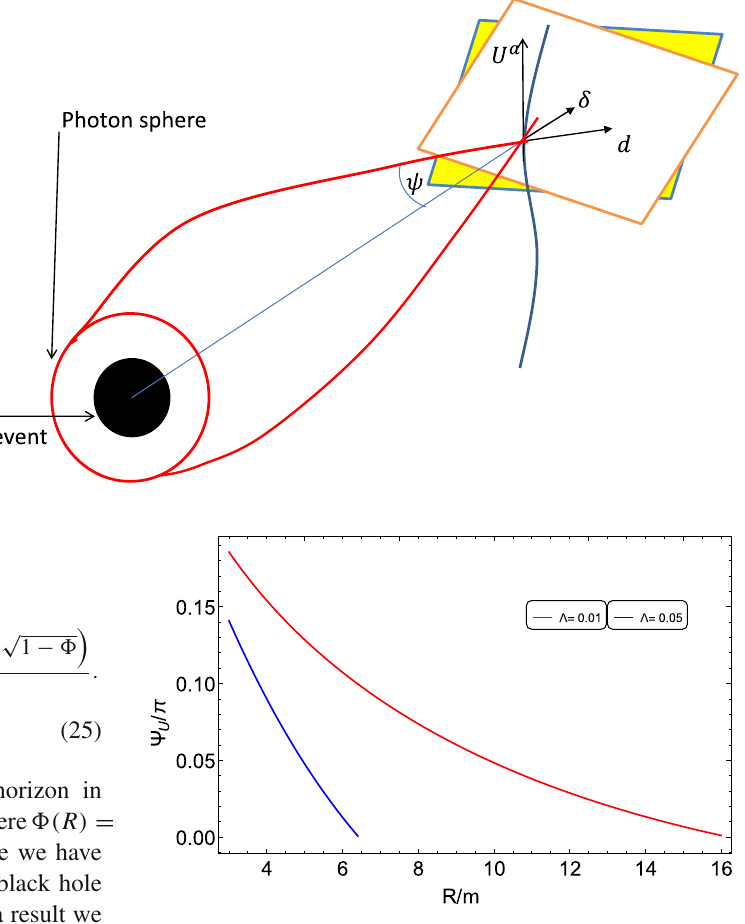
Fig. 2 The observed shadow angle ( ψ U ) for the comoving observer as a function of distance. The blue curve is for (cid:2) = 0 . 05 and the red curve for (cid:2) = 0 . 01. The shadow angle decreases faster for the larger value of the cosmological constant. On the horizon, we have ψ U = 0. We